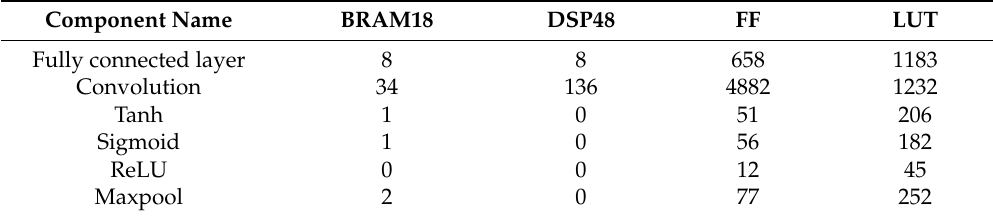
Table 3. FPGA resource usage of synthesized